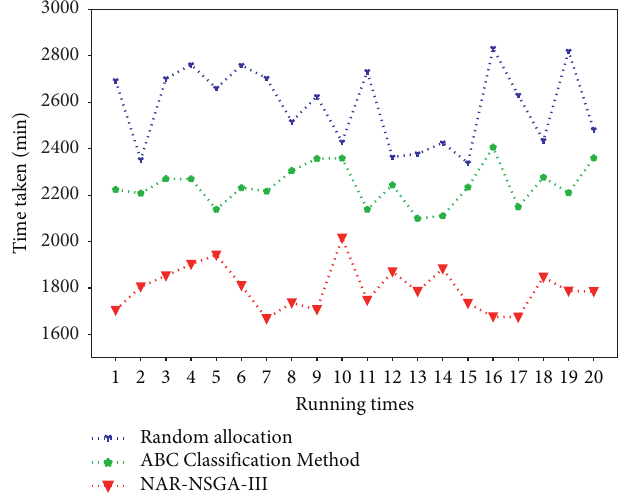
Figure 11: Line graph comparing goods selection